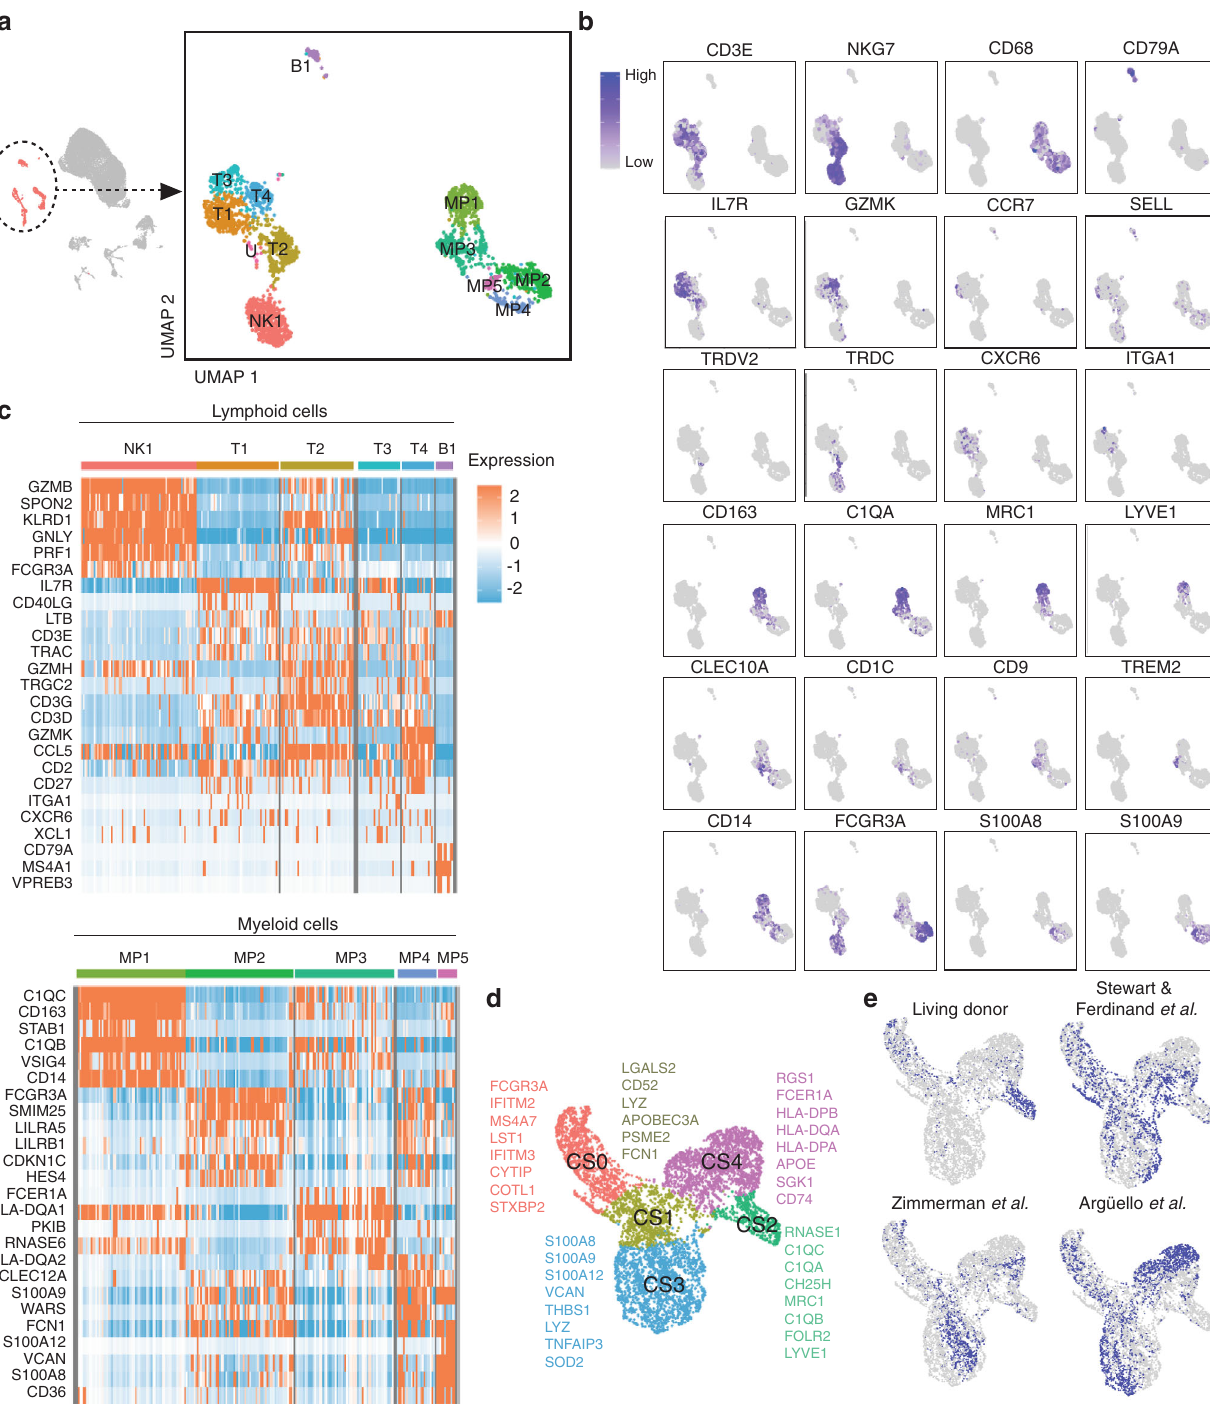
d UMAP plot showing the living donor myeloid cell data clustered together with StewartandFerdinandetal.,Zimmermanetal.,andArgüelloetal.tode fi ne fi vecell states across datasets and their respective cluster markers. e UMAP plots high- lighting the distribution of dataset membership across the cell